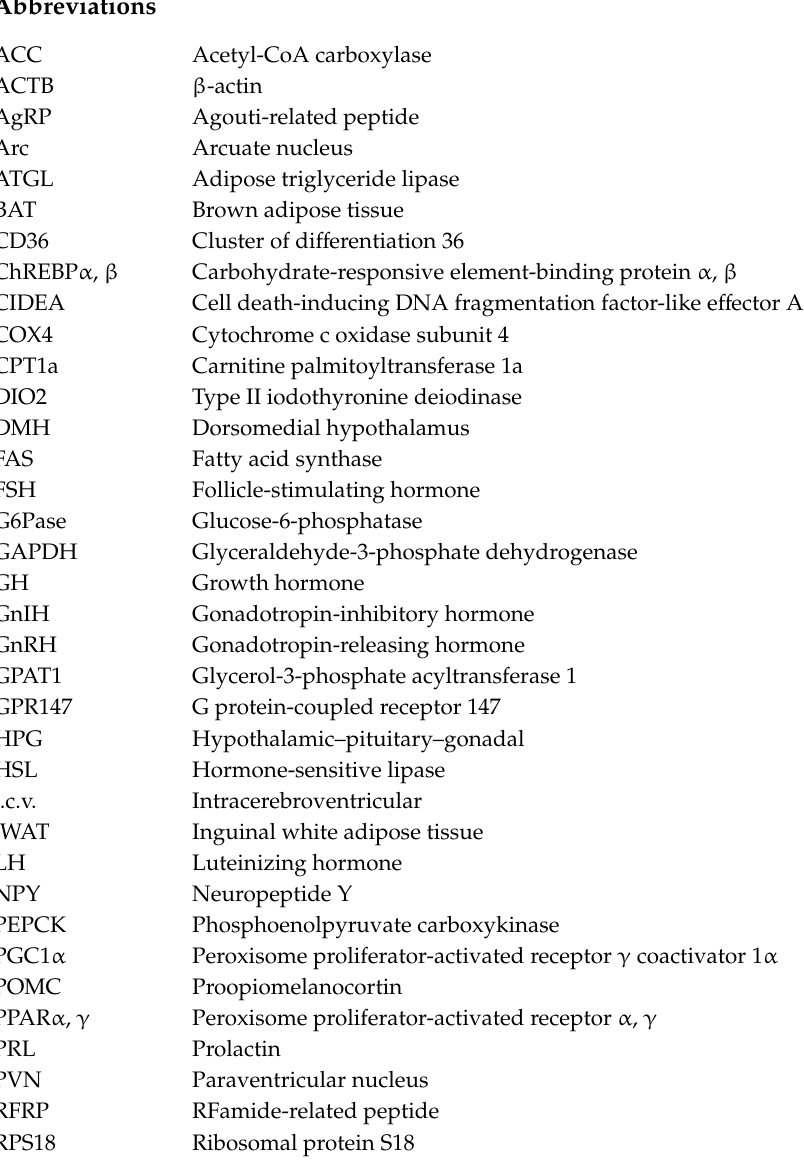
Figure S1: The e ff ects of chronic i.c.v. infusion of RFRP-3 on the mRNA expression of feeding and energy metabolism-related genes in the hypothalamus and pituitary; Figure S2: The e ff ects of chronic i.c.v. infusion of RFRP-3 on the mRNA expression of lipid metabolism-related genes in the adipose tissues (BAT and iWAT) and liver, and thermogenesis-related genes in the